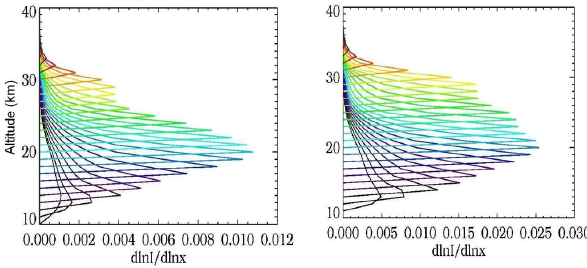
Fig. 5. Same as Fig. 4 now for wavelength 994nm.